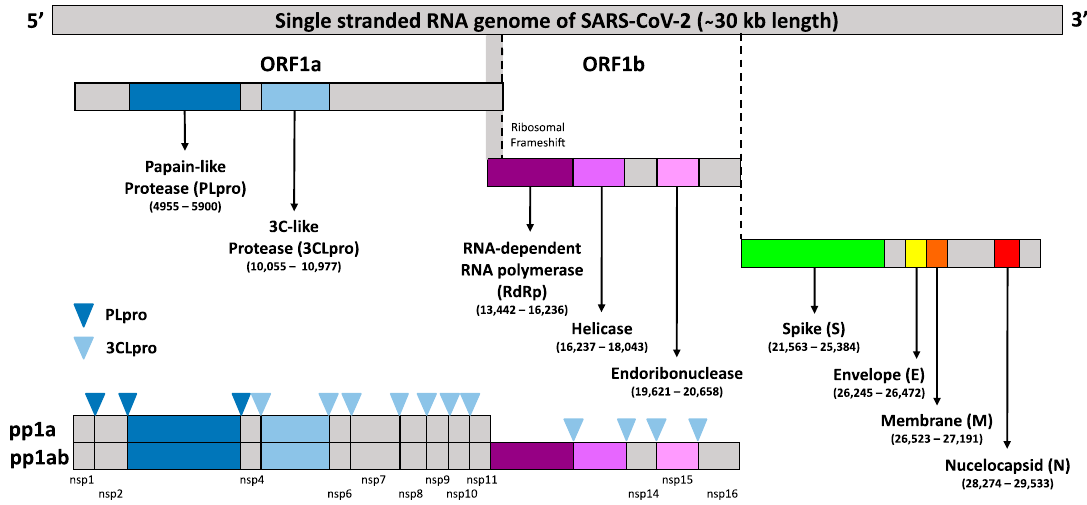
Figure 1. Schematic representation of single stranded SARS-CoV-2 genome structure with ∼ 30 kb nucleotides in length with a 5 (cid:48) cap structure and a 3 (cid:48) -poly(A) tail. The first ORF contains a frameshift in between a-1 of ORF1a and ORF1b which directly translated two polypeptides (pp1a and pp1ab). These polyproteins are processed by one or two papain-like proteases (PLpro) in which the dark blue upside-down triangle sign indicated the cleavage sites of 3CLpro, and by the 3C-like protease (3CLpro) in which the light blue upside-down triangle indicated the cleavage sites of 3CLpro, into the 16 nsps